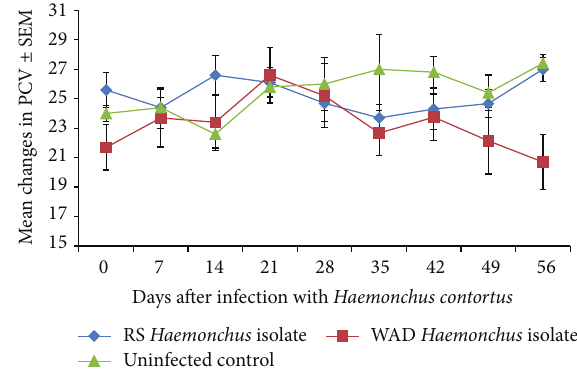
Figure 5: Mean PCV of Nigerian West African Dwarf (WAD) goats given a single pulse infection with either a Red Sokoto (RS) or a WAD goat isolate of H. contortus